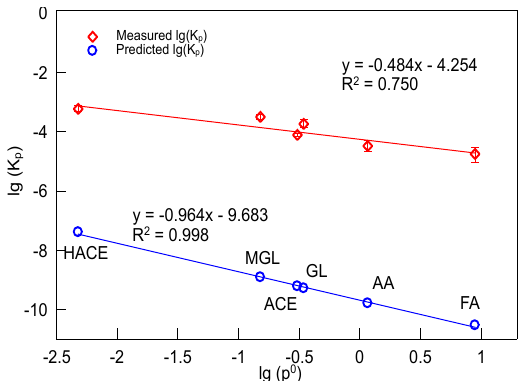
Figure 6. The relationship of measured and predicted partition- ing coefficients (m 3 µg − 1 ) versus vapor pressure (atm) of carbonyls produced in limonene ozonolysis. K p , partitioning coefficients; p 0 , vapor pressure, HACE, hydroxyacetone; FA, formaldehyde; AA, acetaldehyde; ACE, acetone; GL, glyoxal; MGL,